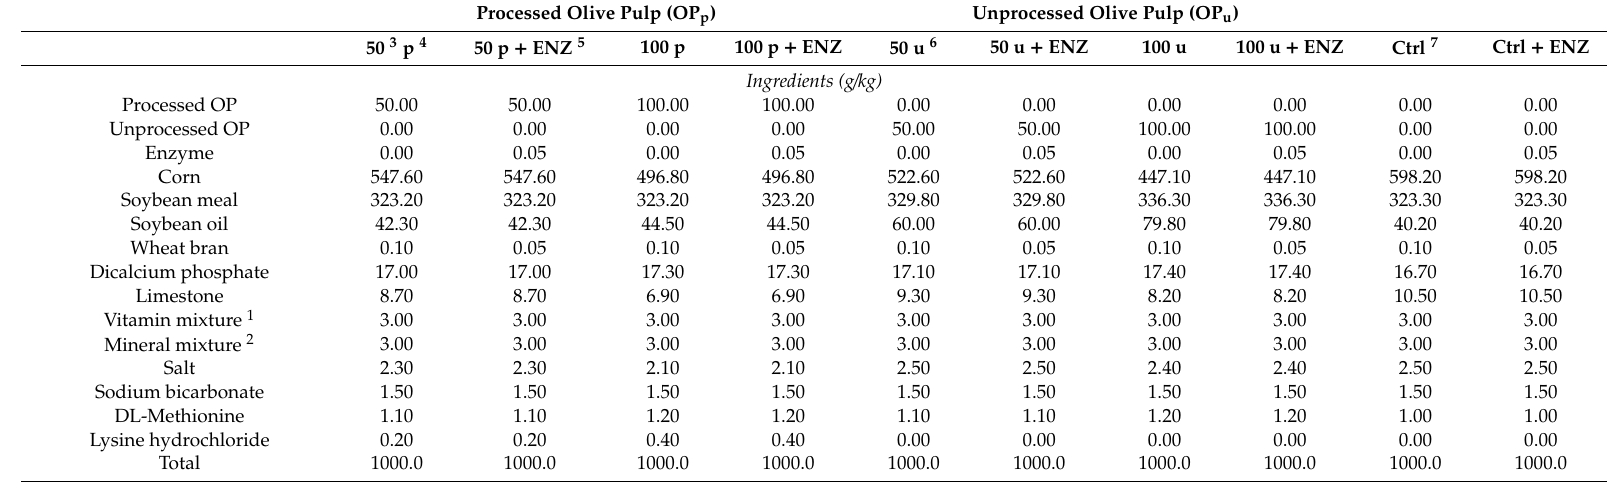
Table 2. Feed ingredients and chemical composition of diets used during the finishing period (22nd–42nd days of age, as-fed